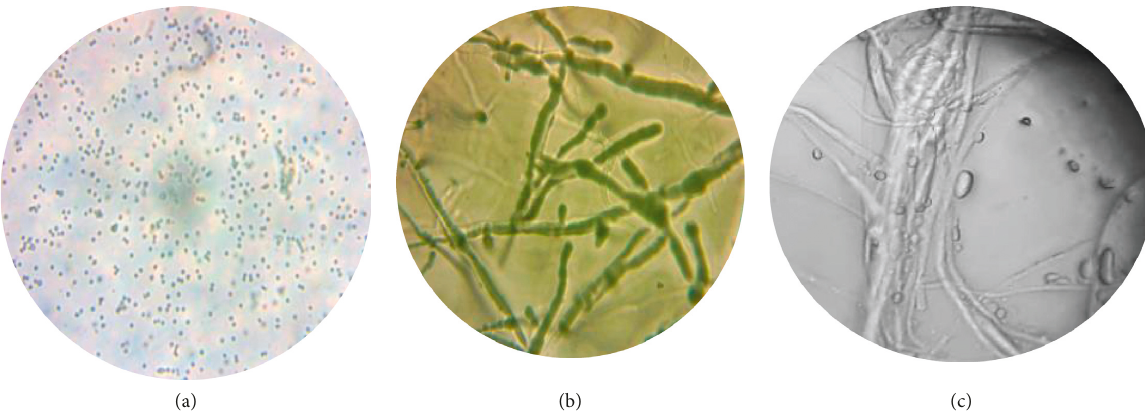
Figure 2: (a) T . viride spore; (b) T. viride mycelia; (c) mass winding and covering effect of T . viride strain against F . oxysporum